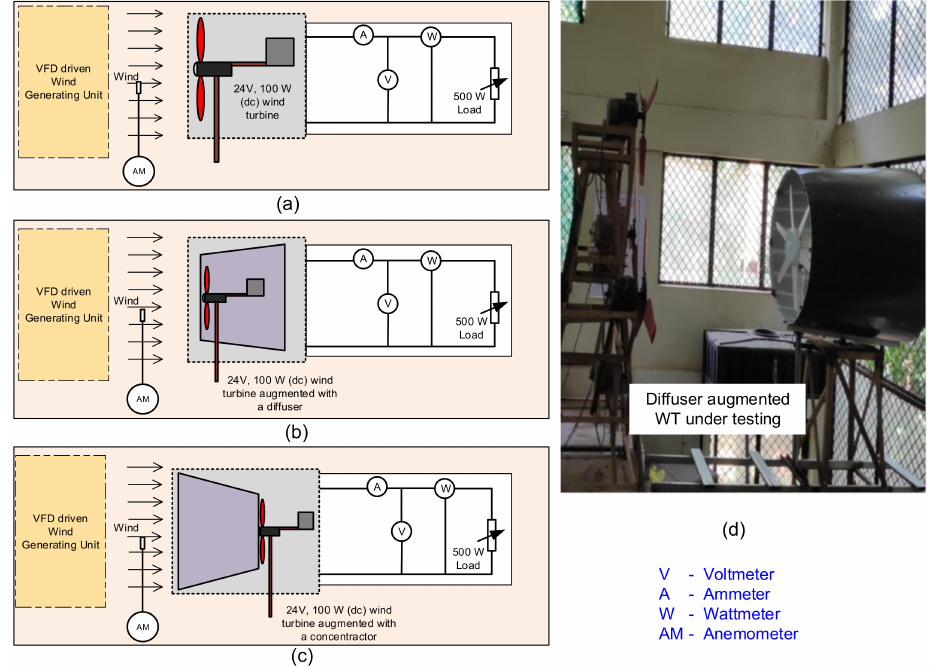
Figure 17. The arrangement for the output-power measurements. ( a ) WT; ( b ) DAWT; ( c ) CAWT; ( d ) DAWT during testing.